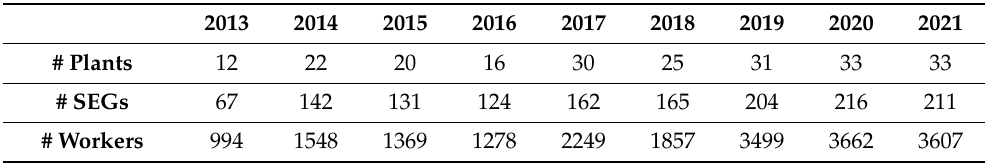
Table 2. Numbers of plants, SEGs and workers in the ICdA cadmium in air workplace monitoring program “OCdAIR” for the period